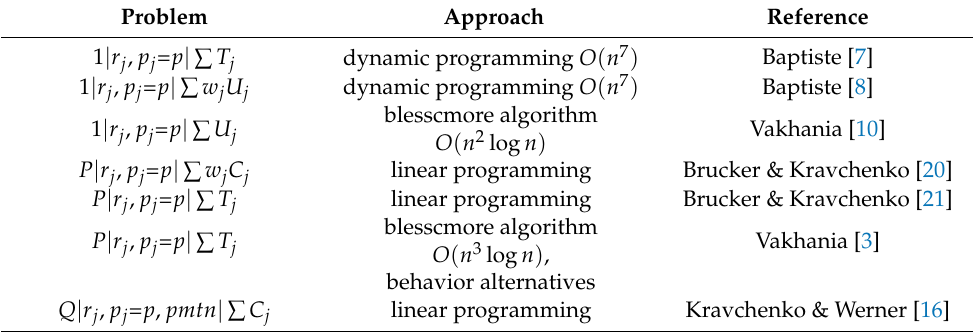
Table 1. Overview of solution approaches for related problems with equal processing